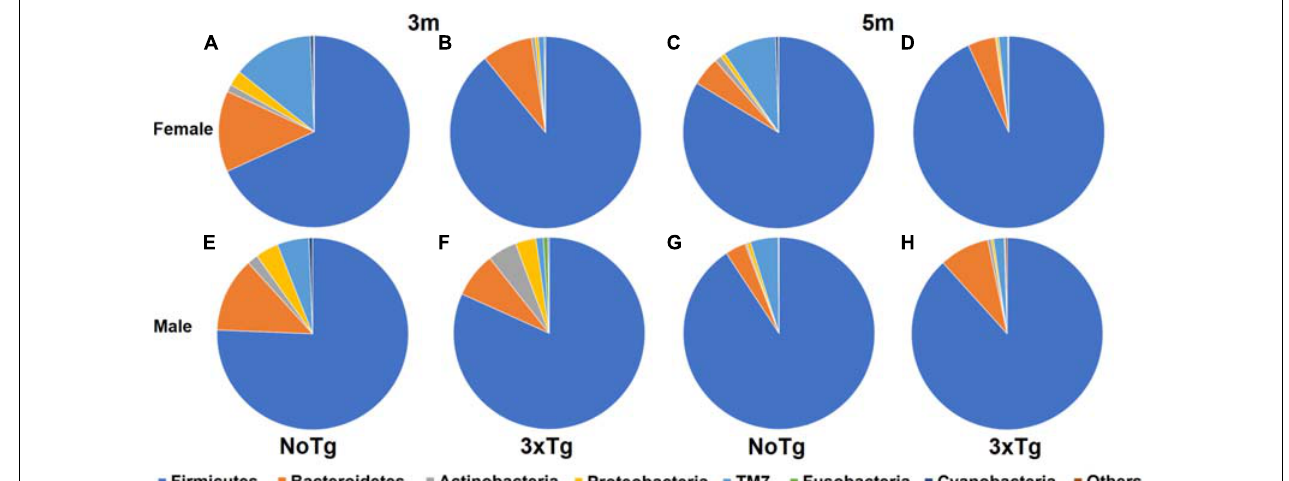
FIGURE 5 | Relative abundance of bacterial phyla in fecal samples of non-transgenic (NoTg) and Alzheimer’s disease triple-transgenic (3xTg-AD) mice. Sectors in pie charts indicate Firmicutes, Bacteroidetes, Actinobacteria, Proteobacteria, TM7, Fusobacteria, and Cyanobacteria phyla as shown by tag colors at the right side of the figure. Abundances of each phylum are shown as percentages beside each sector in the pie charts. “Others” groups phyla with < 0.5% relative abundance (Verrucomicrobia, Acidobacteria, Thermotogae, Chloroflexi, Thermi, Gemmatimonadetes, Tenericutes, Euryarchaeota, FBP, Spirochaetes, and Synergistetes). The figure shows data for 3 and 5 months (m) old for NoTg female (A,C) and male mice (E,G) and for 3xTg-AD female (B,D) and male mice (F,H) ( Supplementary Tables 1, 2